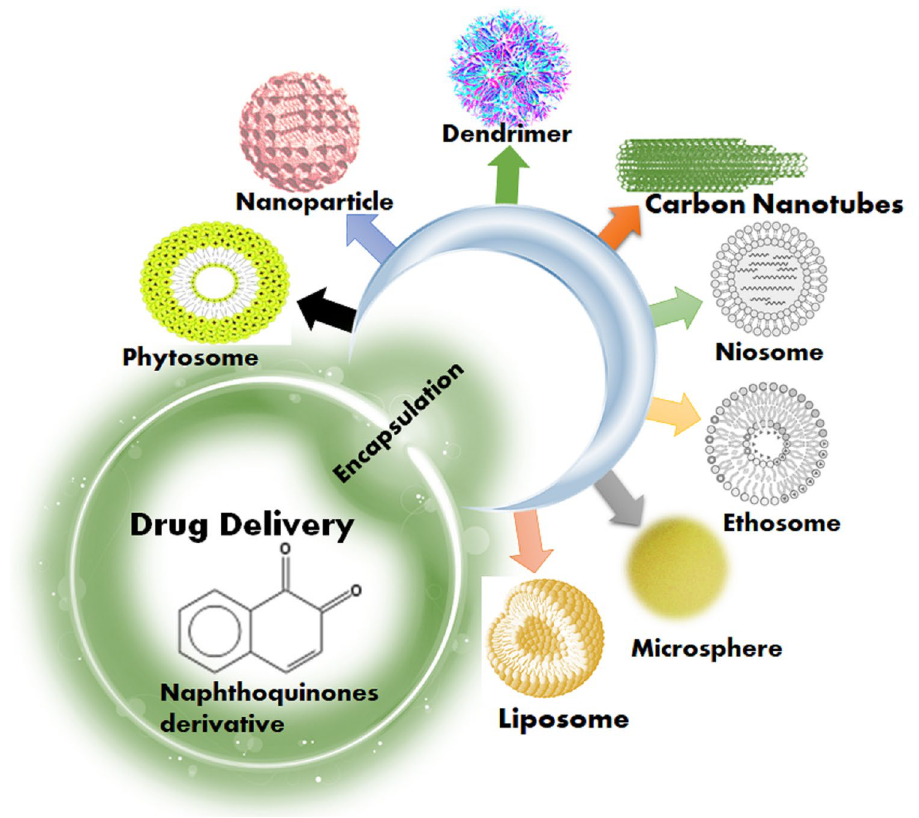
Figure 2. Naphthoquinones encapsulated